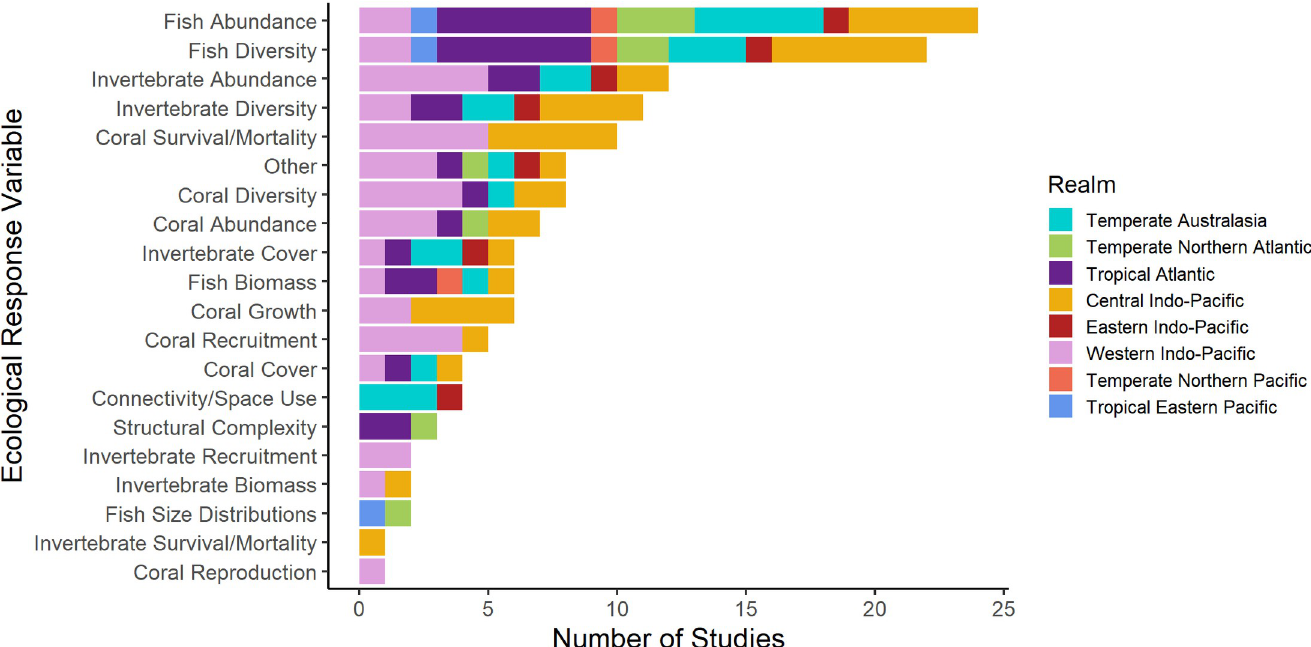
Fig 7. Number of studies that measured each ecological response variable by marine realm (Temperate Australasia, n = 6 study; Temperate Northern Atlantic, n = 4; Tropical Atlantic, n = 9; Central Indo-Pacific, n = 15; Eastern Indo-Pacific, n = 2; Western Indo-Pacific, n = 13; Temperate Northern Pacific, n = 1; Tropical Eastern Pacific, n = 1) in ARs reporting success in meeting conservation objectives. See Fig 2 for map of bioregions.